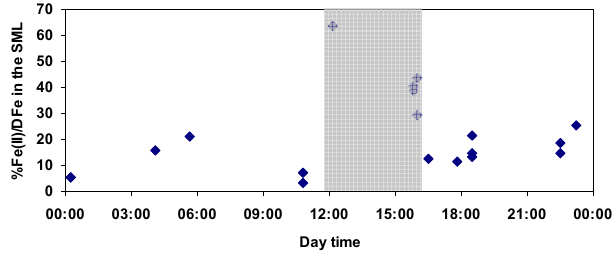
Fig. 6. Percentage of labile Fe(II) relative to dissolved Fe concen- Figure 6 trations in the surface mixed layer for all the stations vs. the time at which sampling was